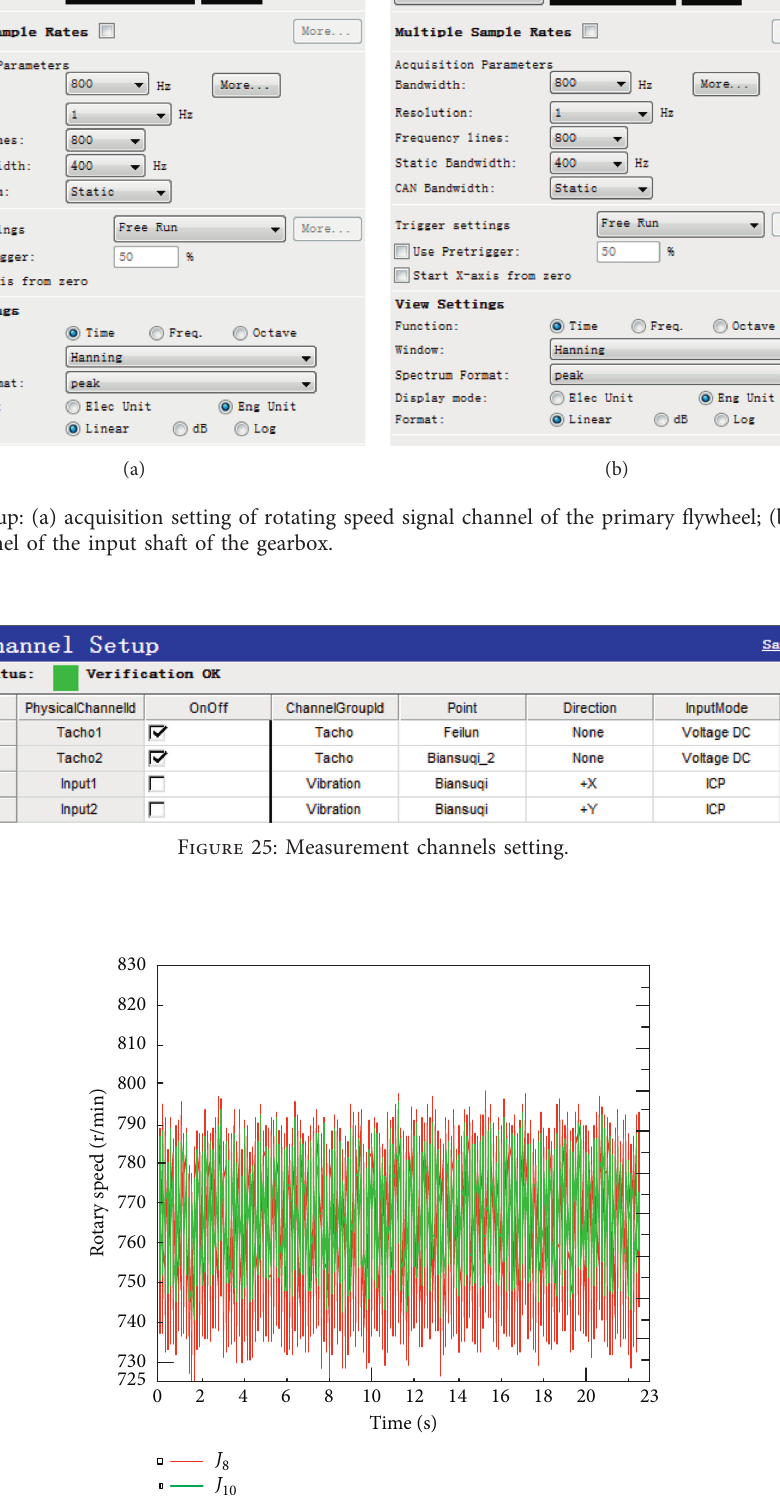
Figure 26: The speed curves of the primary flywheel and the input shaft of the gearbox matching the DMF under the idling